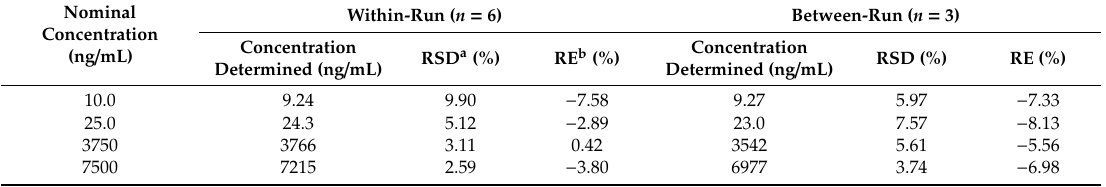
Table 1. Within- and between-run precision and accuracy for ECN measurement in rat plasma.